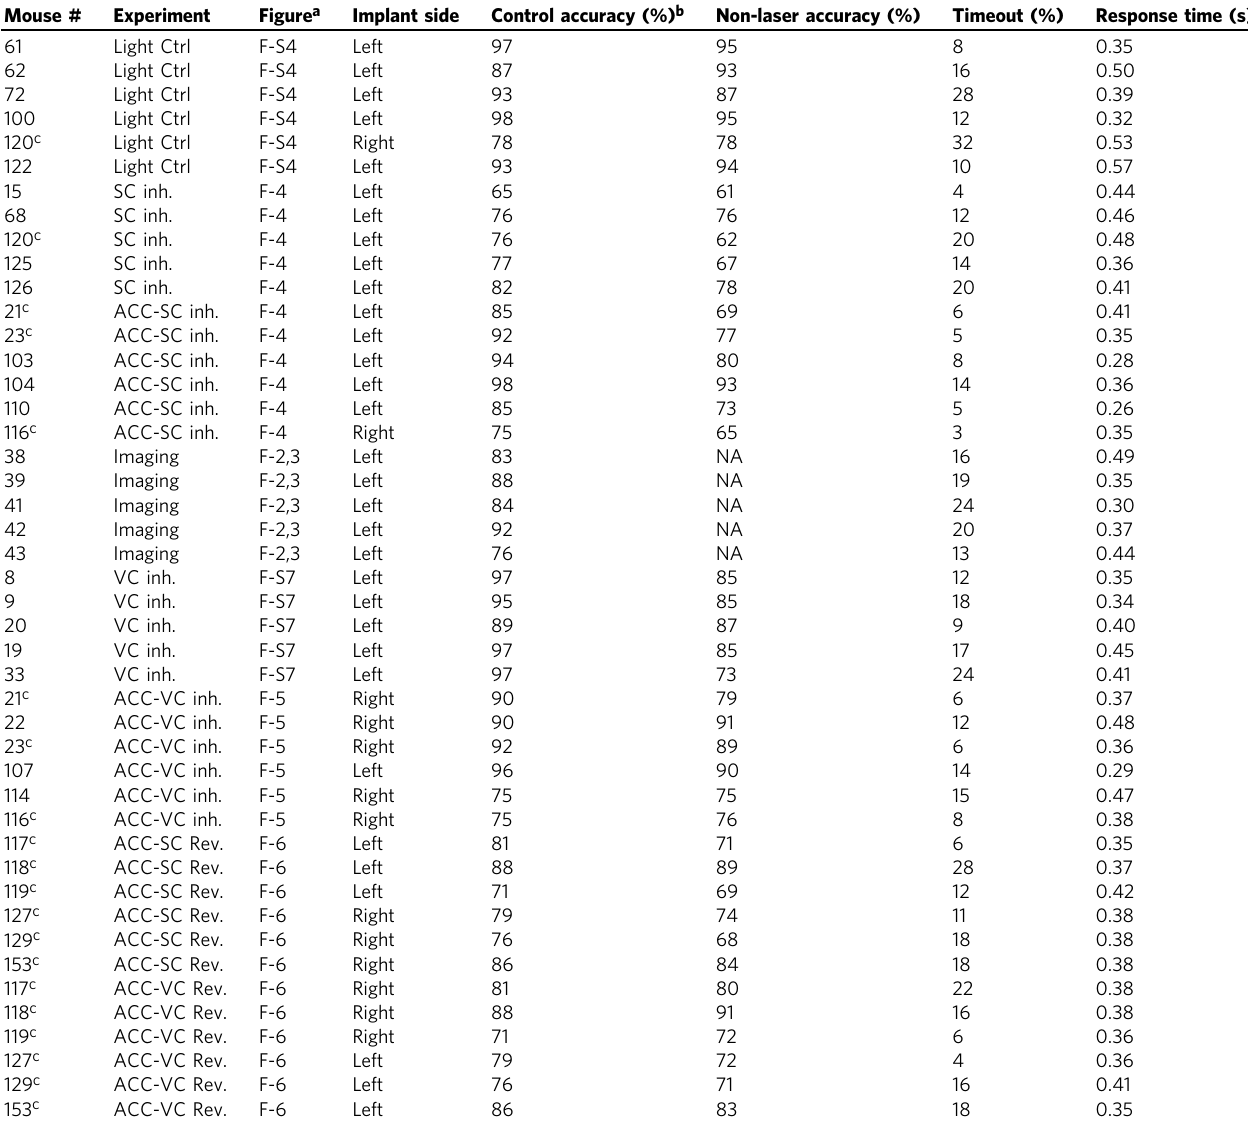
Table 1 Performance metrics of mice included in this study. Mouse